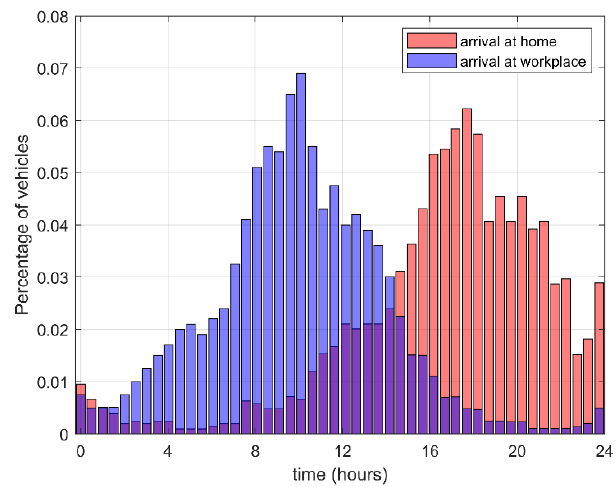
Figure 2. Distribution of arrival time of vehicles at home and workplace.